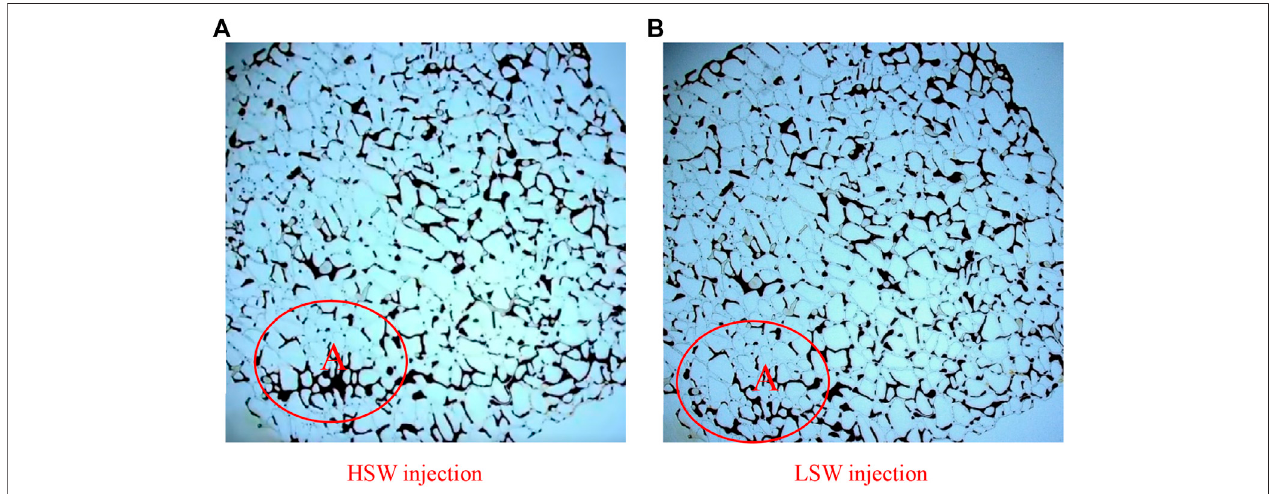
FIGURE 10 | Result of macro-displacement of montmorillonite micromodel under (A) HSW fl ooding and (B) LSW fl ooding.